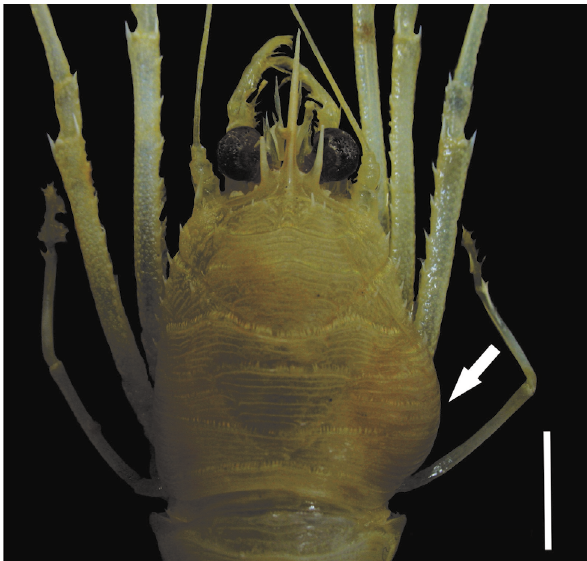
Figure 1. Munida iris A. Milne-Edwards, 1880, female (MOUFPE 17607) parasitized by Anuropodione carolinensis Markham, 1974, collected in Potiguar Basin, #MT–61, 04°47.83’S, 36°11.02’W, 418 m, Rio Grande do Norte, northeastern Brazil. Scale bar = 1